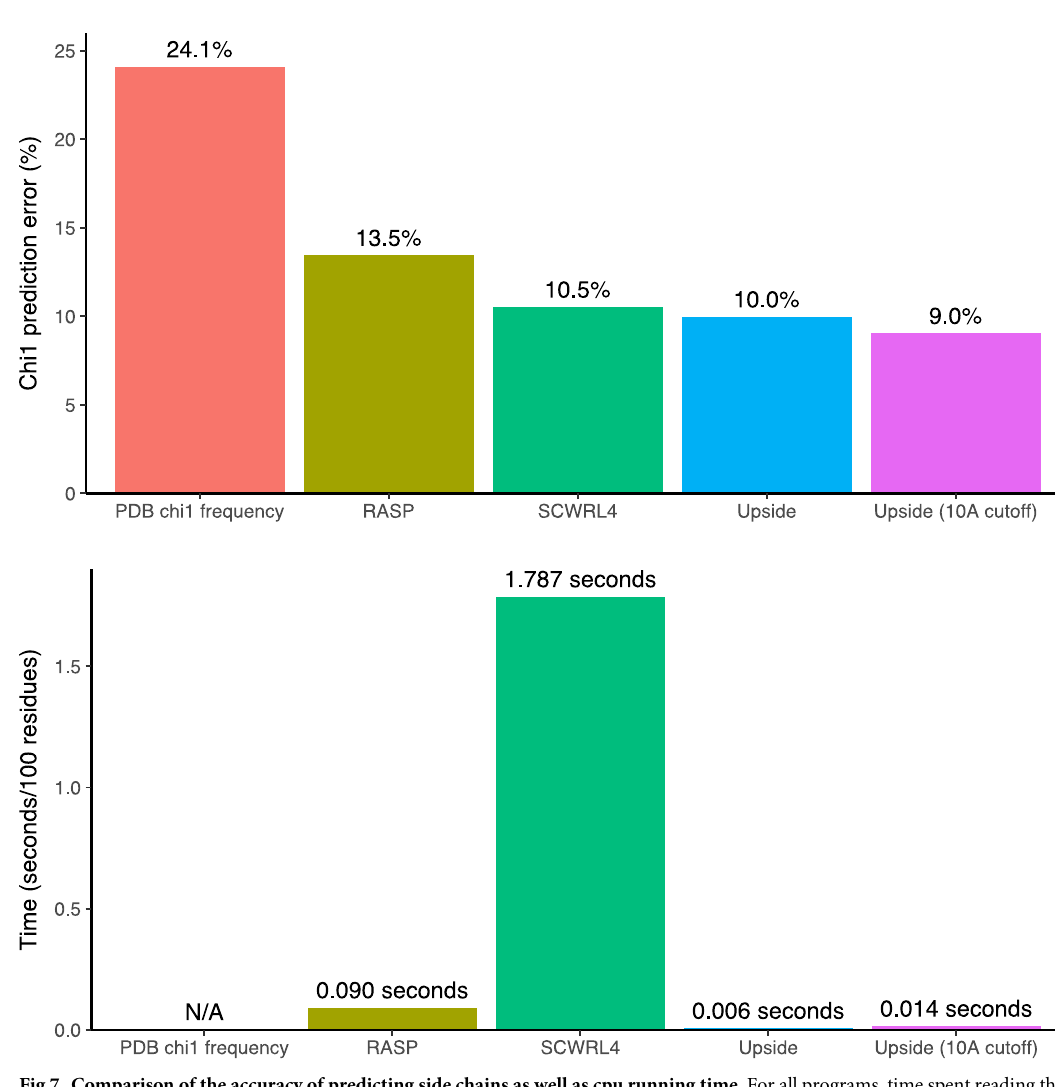
Fig 7. Comparison of the accuracy of predicting side chains as well as cpu running time. For all programs, time spent reading the protein structure and writing the results is excluded from the running time to focus on the cost of solving for the side chain positions. For Upside (10 Å cutoff), all side chain interactions with backbone or other side chains are cutoff at 10 Å